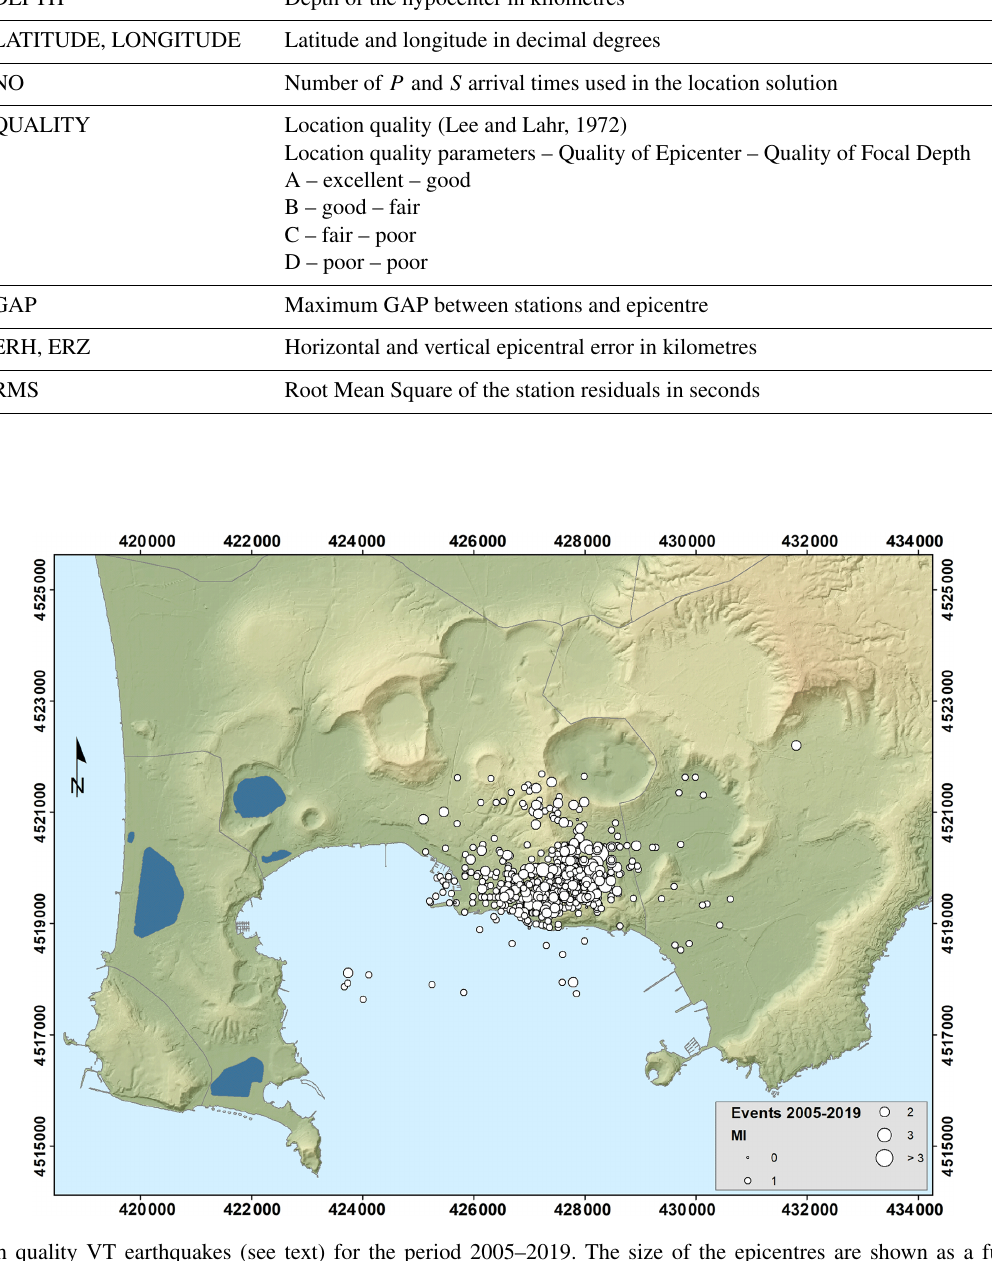
Figure 2. High quality VT earthquakes (see text) for the period 2005–2019. The size of the epicentres are shown as a function of the magnitude according to the legend on the bottom right. DTM of Campi Flegrei (Vilardo et al., 2013). Reference system UTM